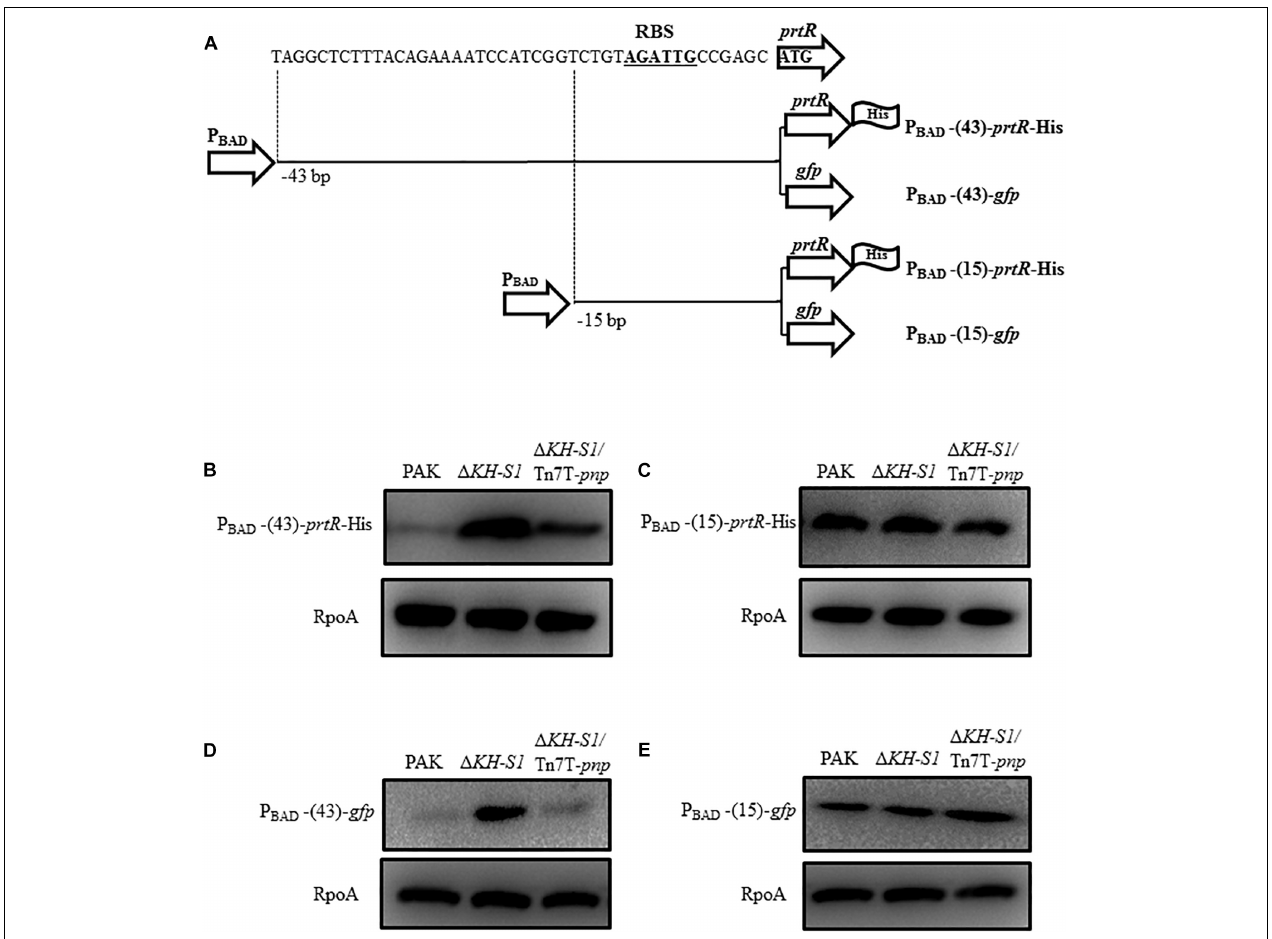
FIGURE 6 | Translational regulation of prtR by the PNPase. (A) Structures of the 6 × His-tagged prtR fusions. P BAD -43- prtR -His and P BAD -15- prtR -His represent 6 × His-tagged prtR driven by the P BAD promoter with 43 and 15 bp of the 5 (cid:48) -UTR sequence of the prtR gene, respectively. The prtR open reading frame was replaced by a gfp gene, resulting in P BAD -43- gfp and P BAD -15- gfp . The potential ribosome binding site (RBS) was shown in bold underlined letters. Strains containing the prtR -His or gfp expression plasmid were grown to an OD 600 of 1.0 and then induced with 0.2% arabinose for 1.5 h. Protein levels of PrtR (B,C) and GFP (D,E) were determined by Western blotting. RpoA was used as the loading